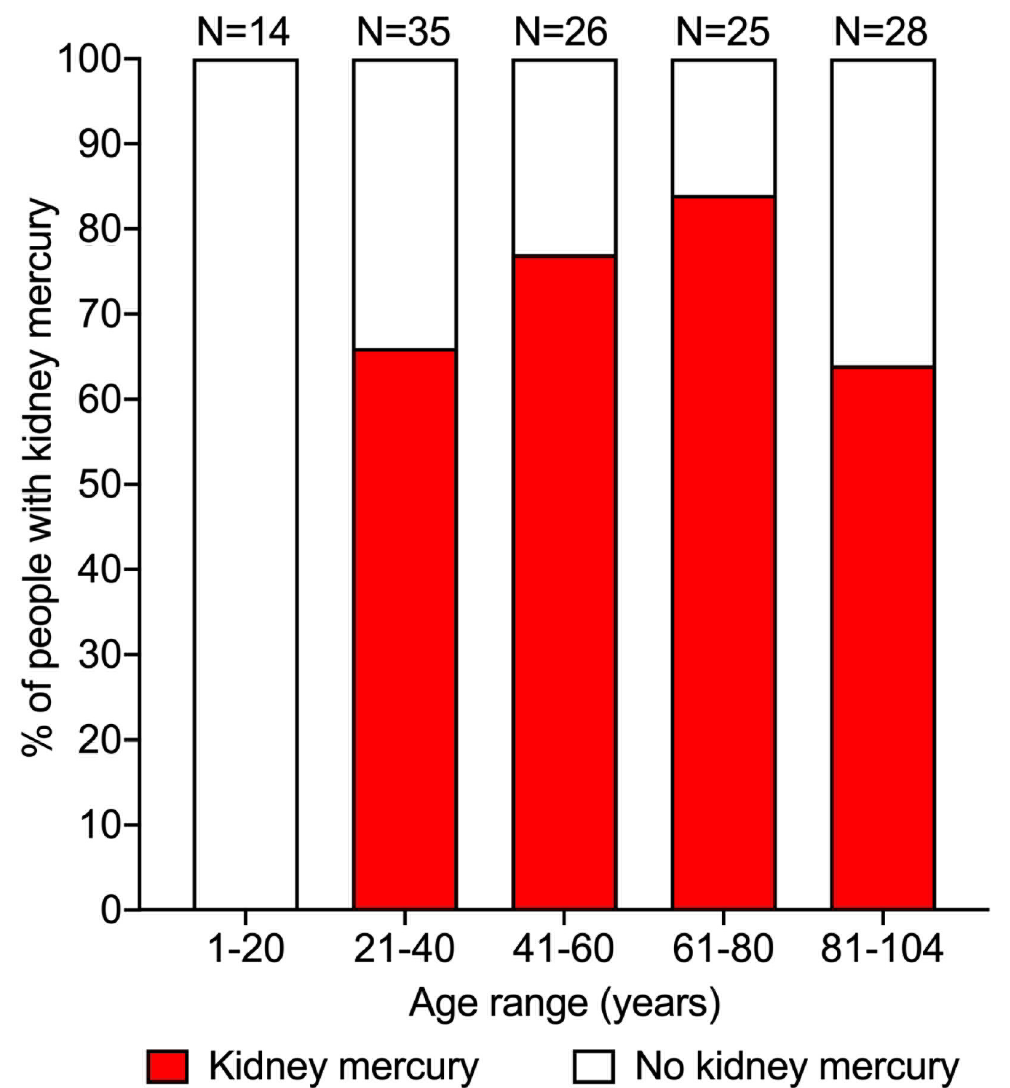
Figure 4. Prevalence of mercury in the human kidney at different ages. No kidney mercury was seen in the first two decades of life. In the 41–60 years age range, mercury was found in 66% of people, rising to 77% in the 41–60 years group and 84% in the 61–80 years group, before falling to 64% in the 81–104 years age range. Numbers above bars = numbers in age groups.